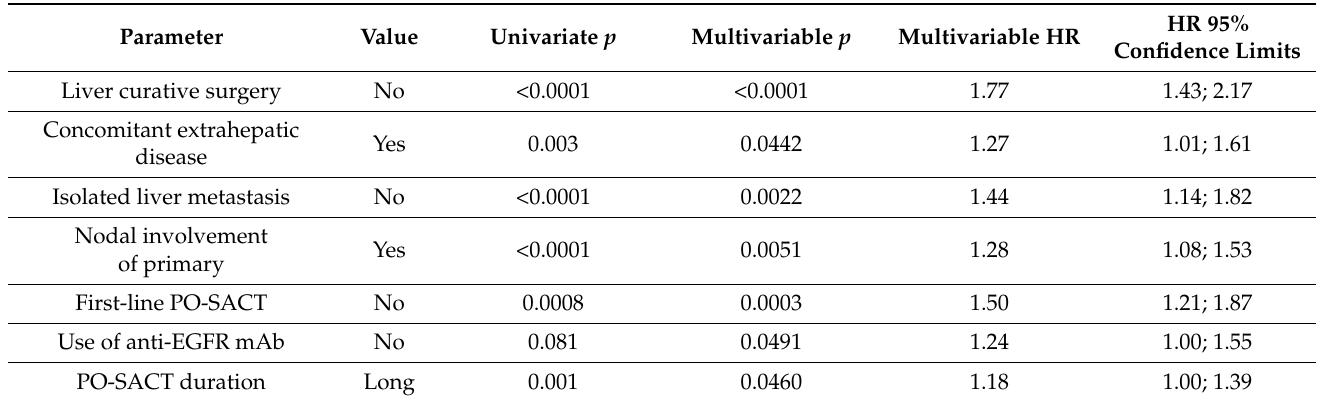
Table 2. Multivariable proportional hazard Cox models for overall